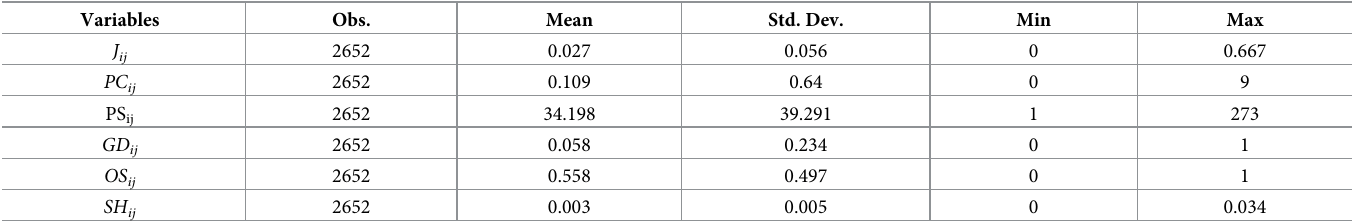
Table 5. Descriptive